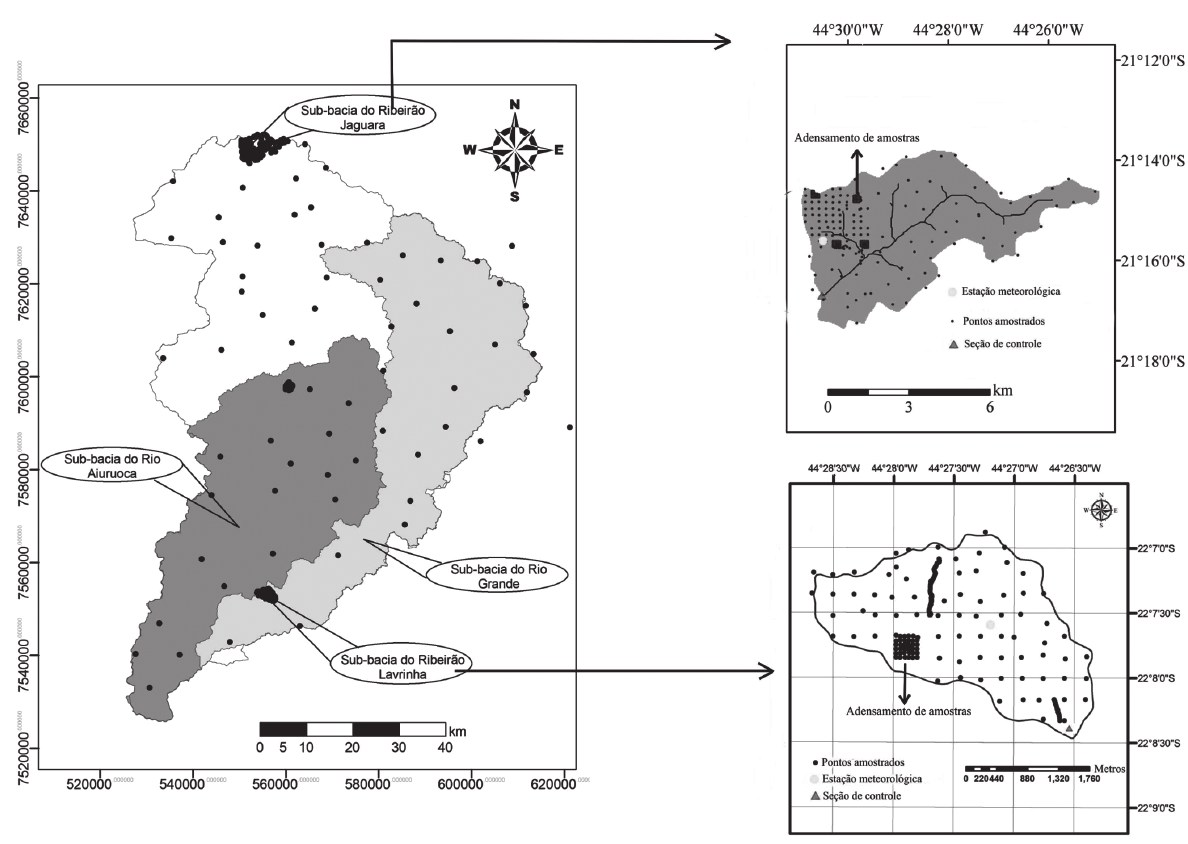
Figura 3. Pontos amostrados e localização das sub-bacias hidrográficas estudadas na Bacia Hidrográfica do Alto Rio Grande,